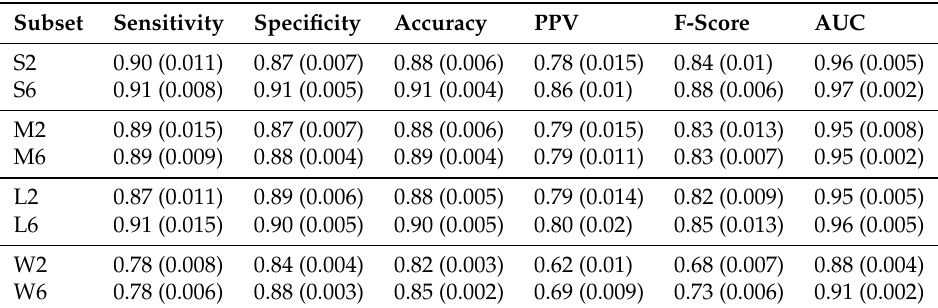
Table 8. Predictive performance of random forest based on the estimated sensitivity, specificity, accuracy, positive predictive value (PPV), F-score and the area under receiver operating characteristic curve (AUC) for two-week and six-week restriction periods among the cows in early (S), mid (M) and late (L) lactation stage using cross validation